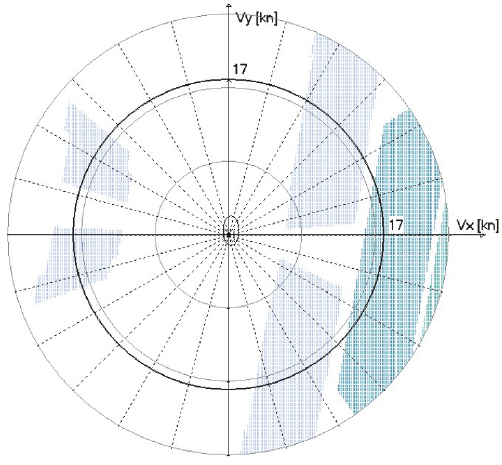
Figure 31: Sectors of own course and speed eliminated by risk of successive high wave attack (turquoise) and resonance (light blue) for wind of 17 [m/s] and wave from 280 ∘ .